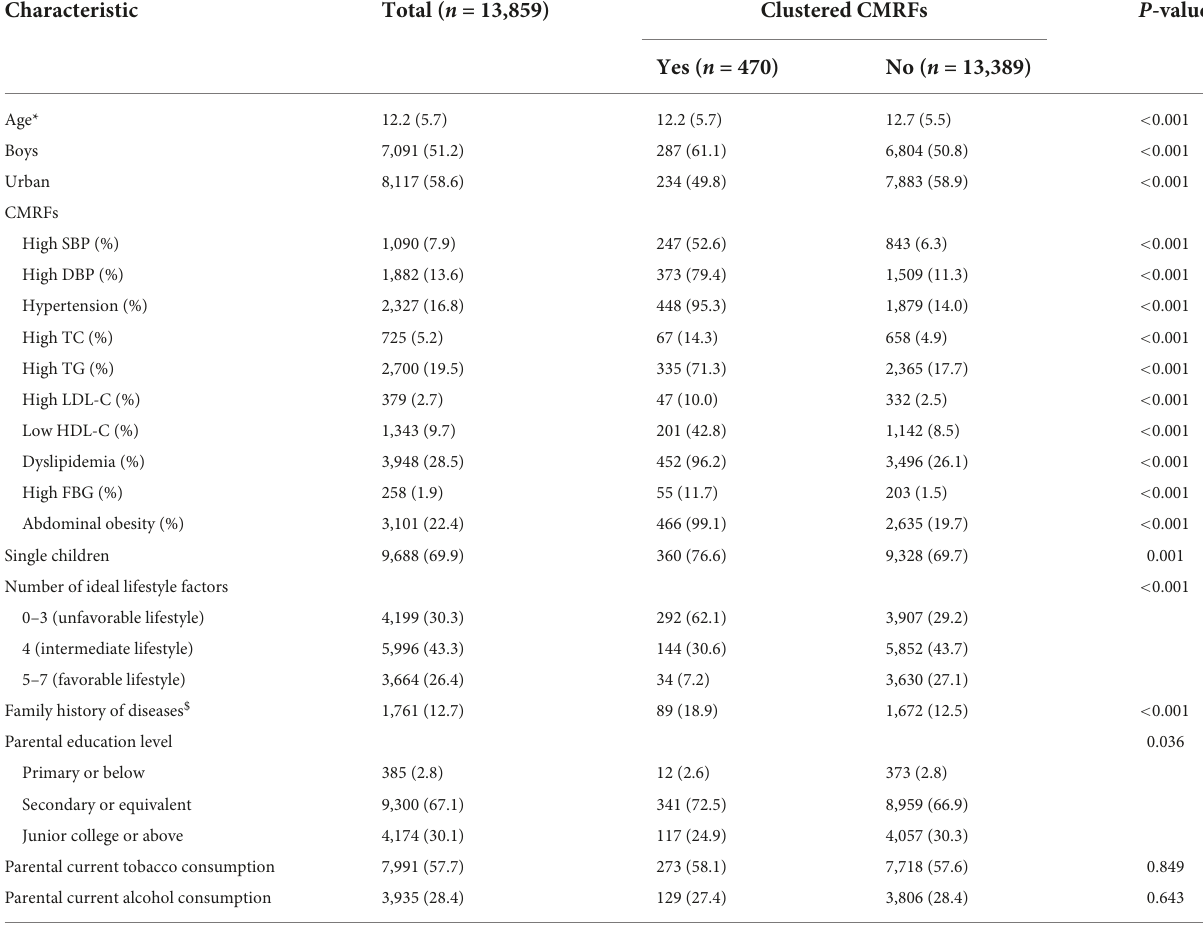
TABLE 1 Demographic characteristics of eligible children and adolescents and their parents, stratified by clustered cardio-metabolic risk factors (CMRFs). Characteristic Total ( n = 13,859) Clustered